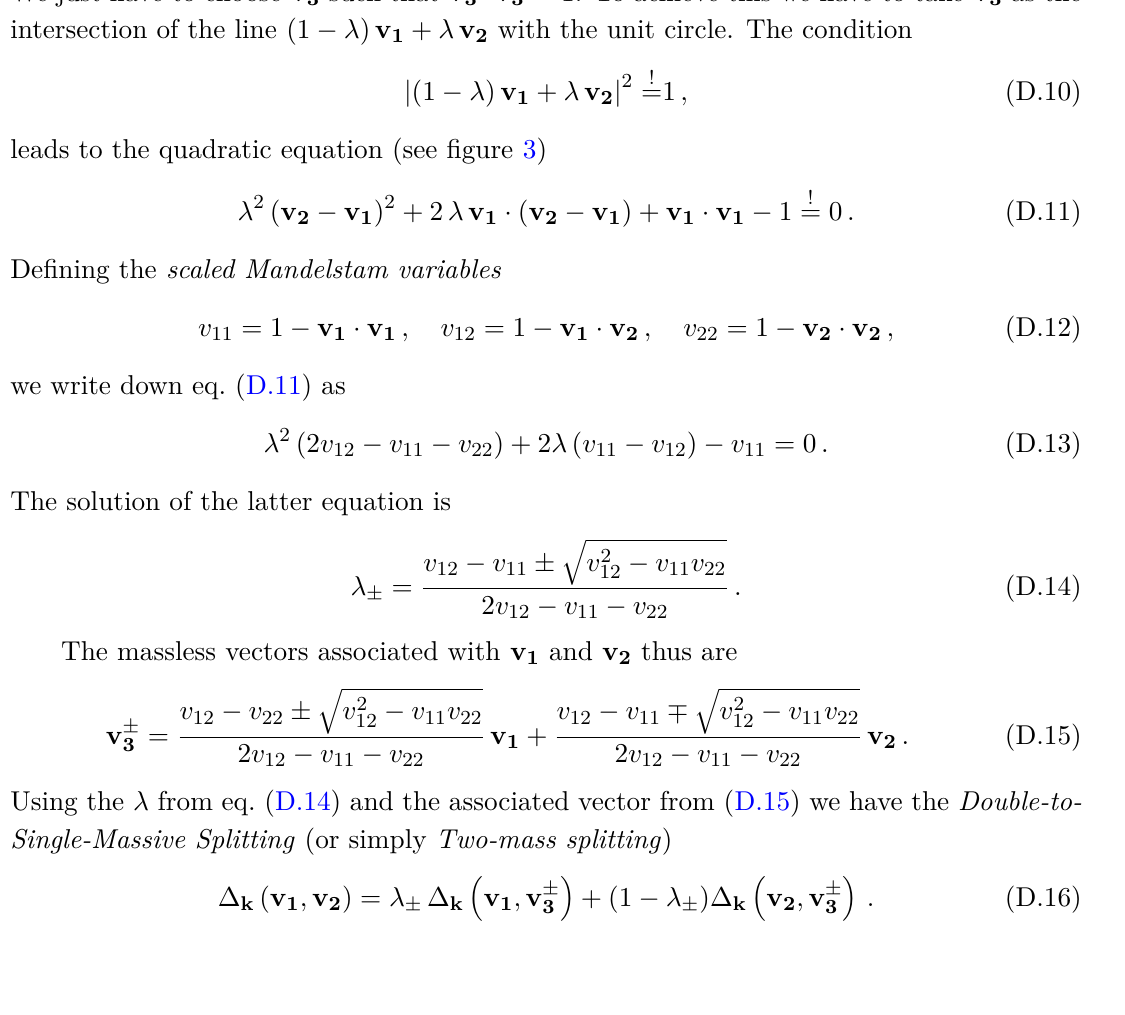
Figure 3 . Graphical representation of double-to-single-massive splitting. v ± the intersections of the unit circle with the line through v 1 and v 2